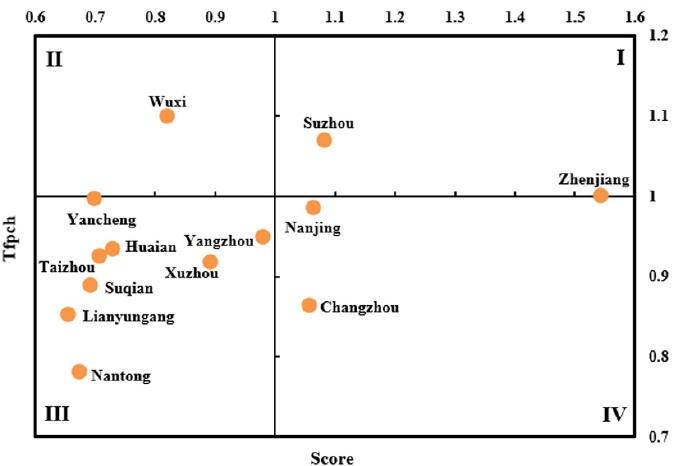
Figure 4. Classification of cities in Jiangsu Province based on the comprehensive measurement of efficiency from 2015 to 2019.